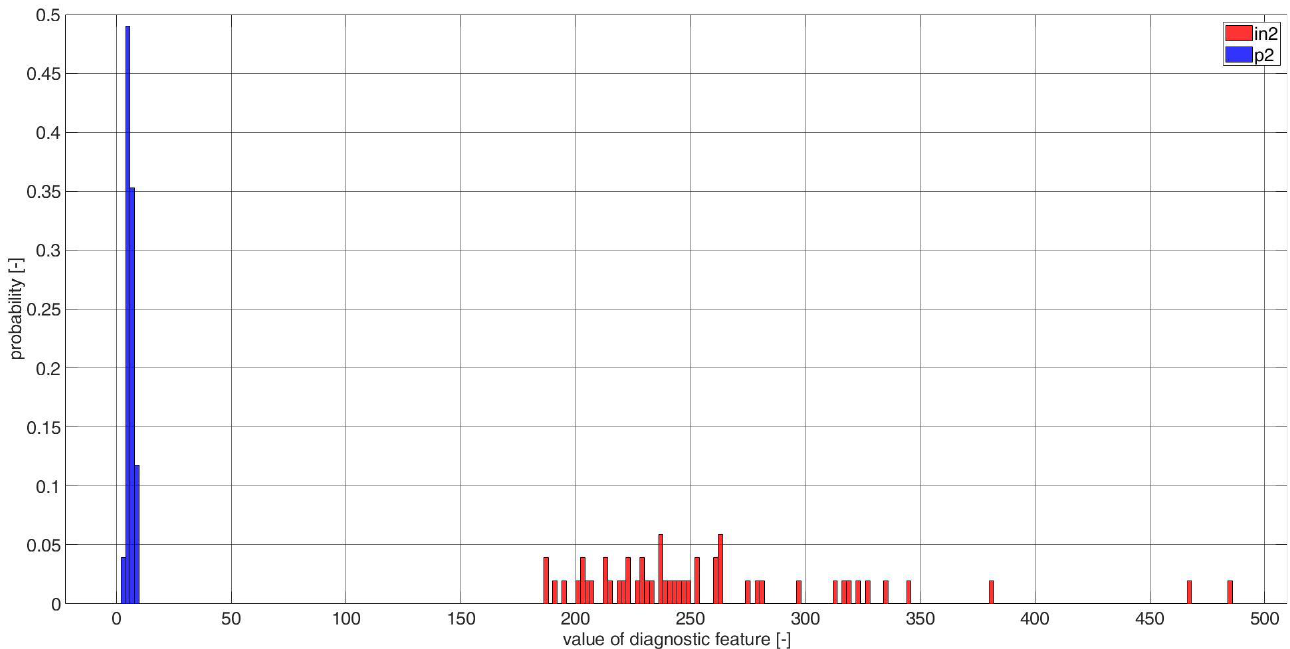
Figure A5. Histograms of diagnostic features based on the CCSM3 (correlation number is 6 — Table A1) bearings in1 and p1.